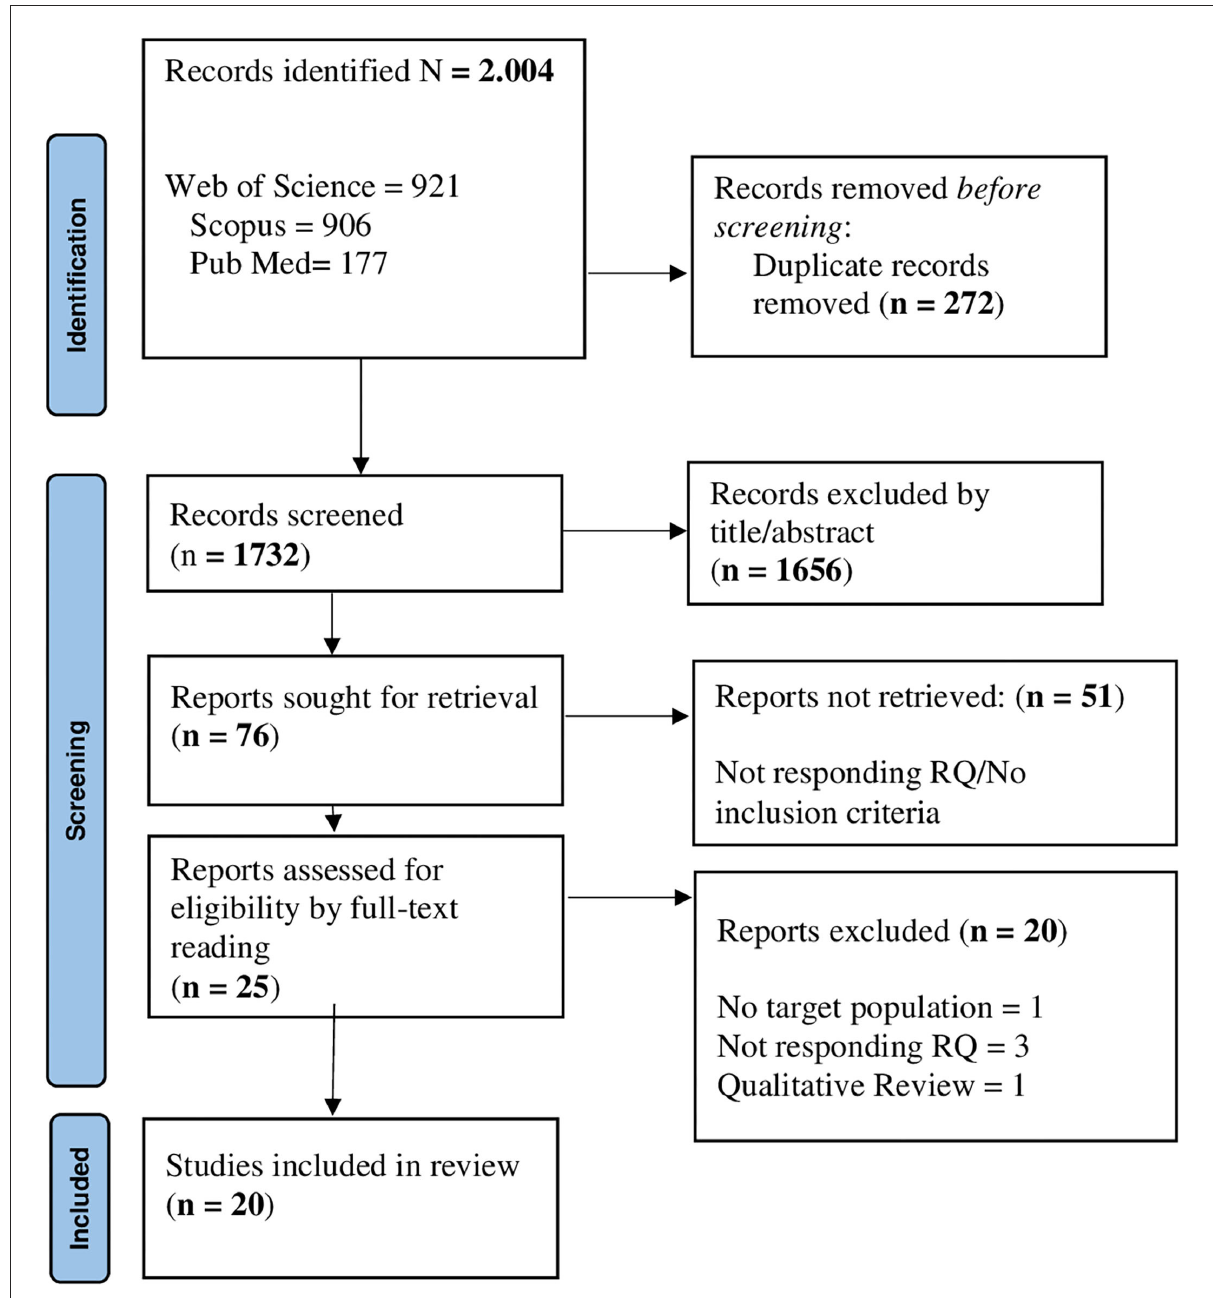
FIGURE4 PRISMA flowchart for the factors are associated with HE students’ basic need satisfaction and